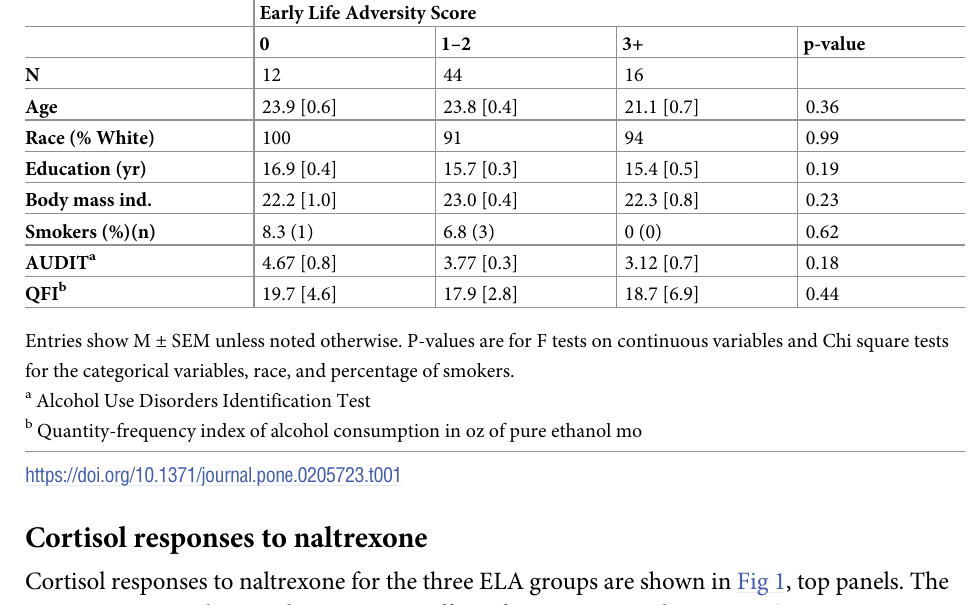
Table 1. Demographic and biomorphic characteristics of ELA groups.